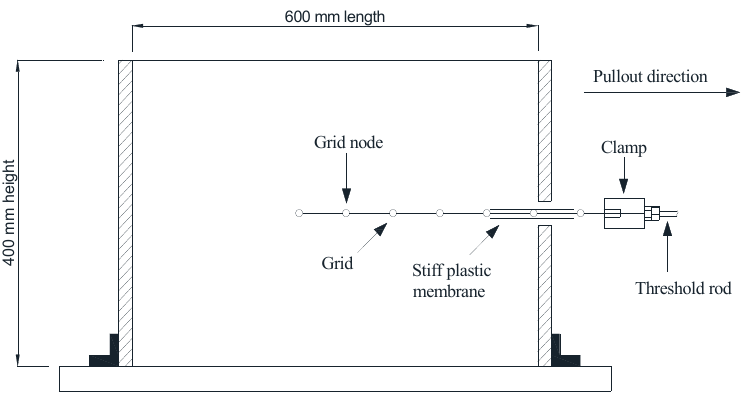
Figure 1. Large box pullout test set-up in the laboratory.